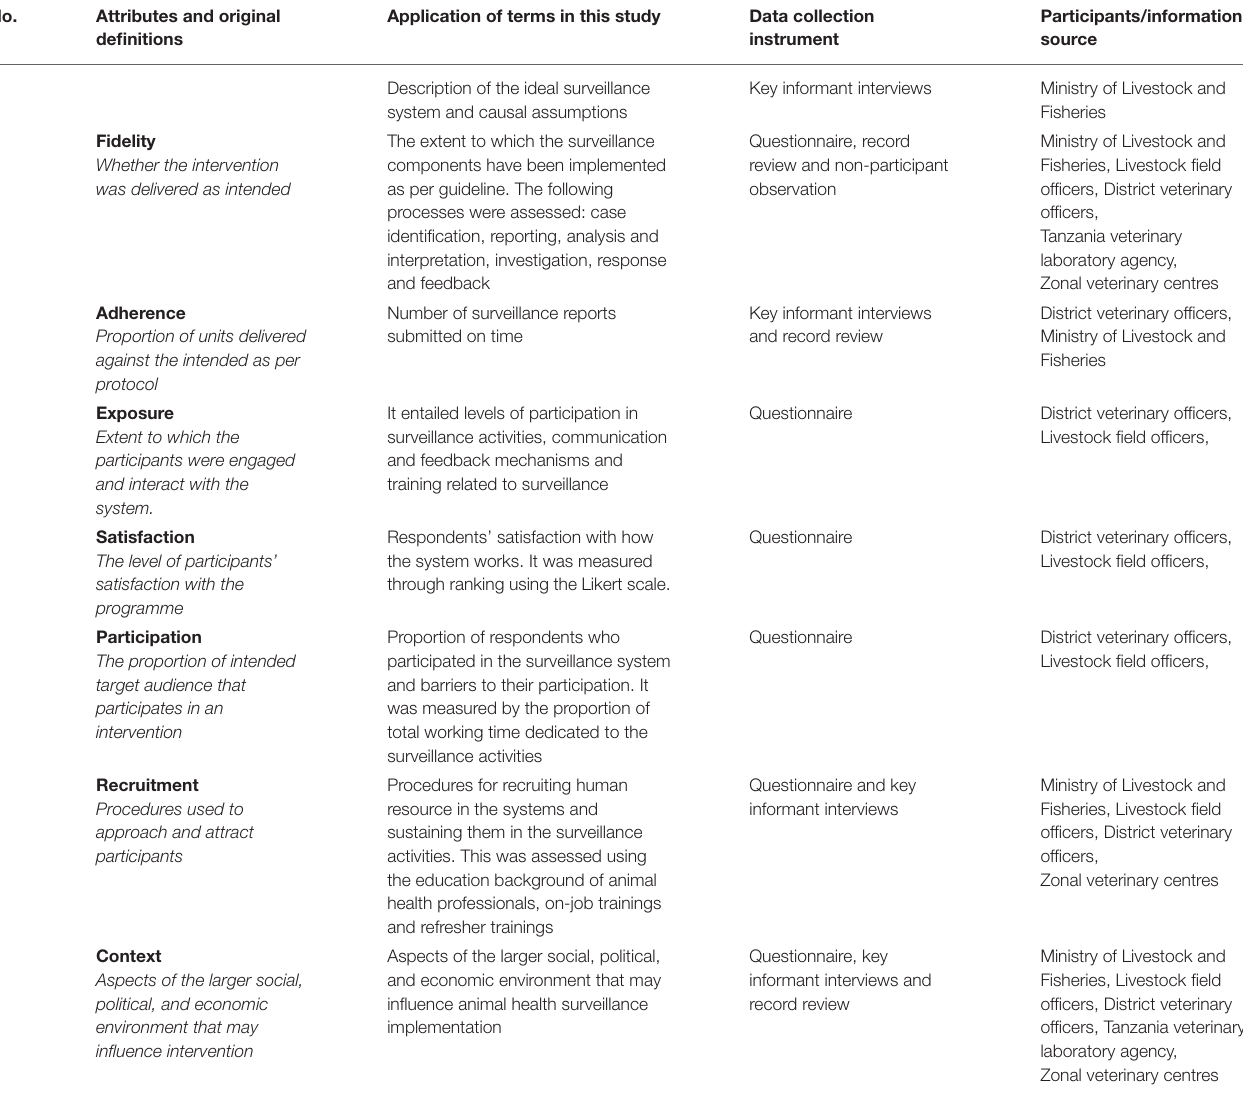
TABLE 1 | Process evaluation attributes and data collection